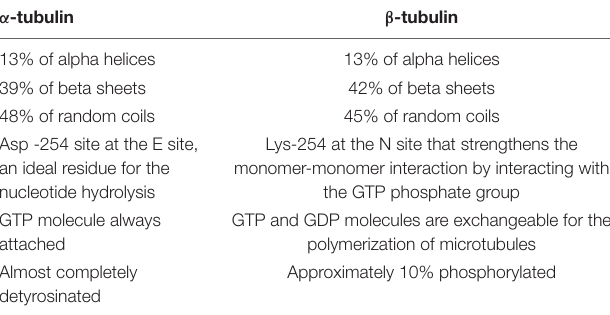
TABLE 2 | Structural differences between α - and β -tubulin (modified after Nogales et al., 1998; Nogales,